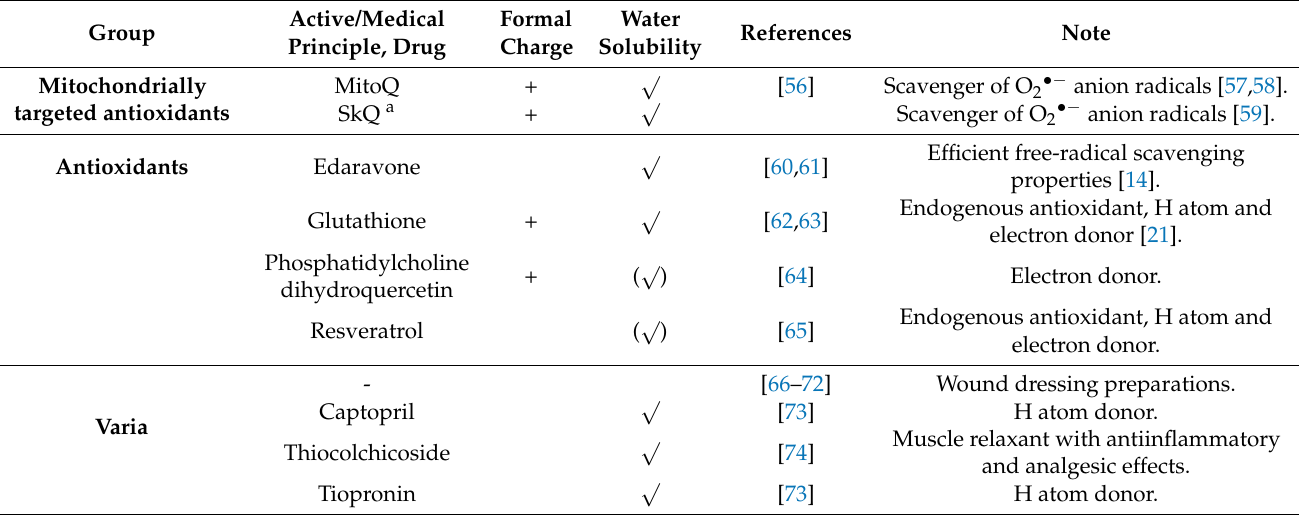
Table 2. Active/medical principle or a drug incorporated into composite membranes of chitosan and hyaluronan.